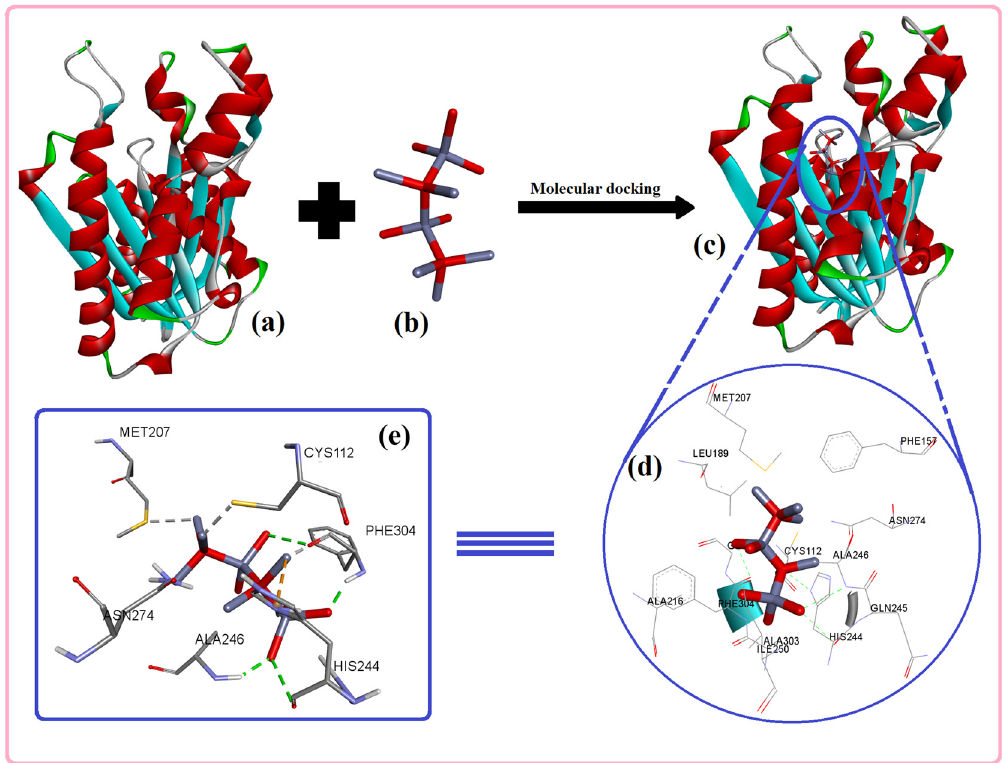
Figure 7: Molecular docking study of ( a ) receptor, ( b ) ligand ( ZnO ) , ( c ) best docking pose and ( d and e ) various ZnO interactions with amino acids contribute to cavity